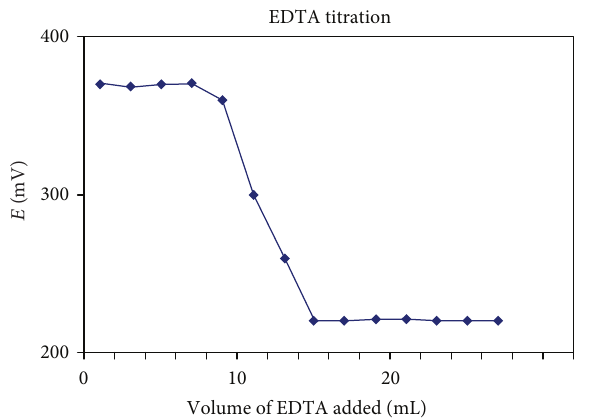
F 6: Potentiometric titration curve of